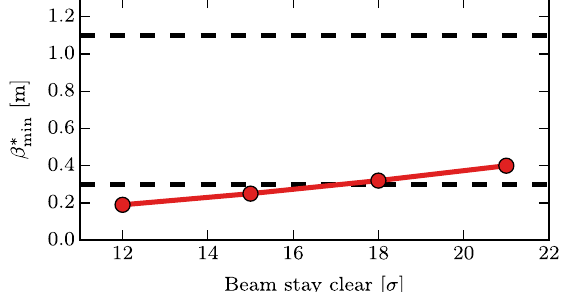
FIG. 8. β (cid:2) reach of the L (cid:2) ¼ 61 m lattice for beam stay clear requirements of 12 – 21 σ . The reachable β (cid:2) is very similar to the one of the L (cid:2) ¼ 36 m lattice with individual apertures. Note that the triplet magnets in the L (cid:2) ¼ 61 m all have similar gradients, so all apertures are the